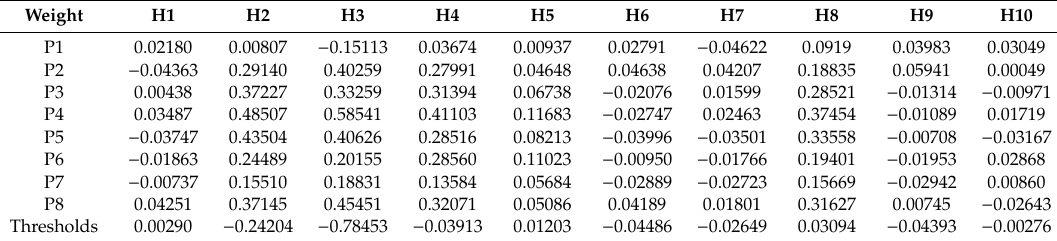
Table 5. Input layer to hidden layer weights and thresholds.